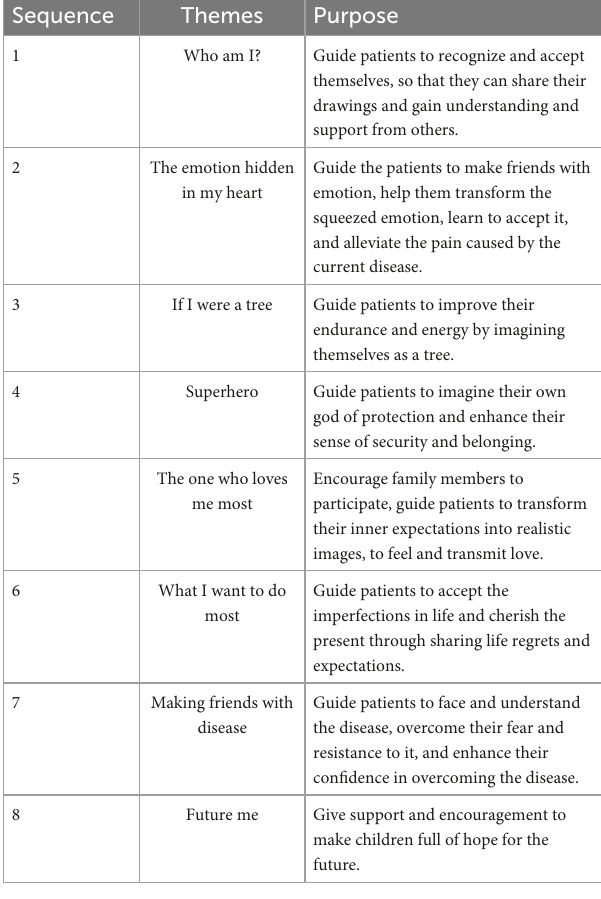
TABLE 1 List of themes for group drawing art